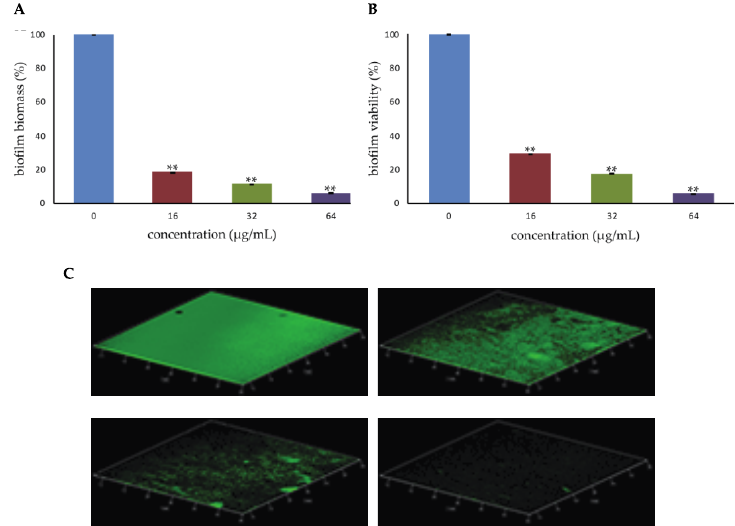
Figure 2. Eradicating e ff ect of PYED-1 on S. aureus preformed biofilm. Biofilm formed after 48 h in 96-well microplates was treated with di ff erent PYED-1 concentrations for 24 h at 37 ◦ C under static conditions. ( A ) Biofilm biomass were measured by crystal violet (CV) staining. ( B ) Biofilm viability was measured by tetrazolium salt reduction (XTT) assay. Error bars represent the standard deviation (SD) of three independent experiments. Asterisks indicate statistically significant di ff erences between the treated and untreated biofilms (** p < 0.01). ( C ) CLSM analysis of preformed S. aureus ATCC 29213 biofilm without treatment (left upper panel) or treated with PYED-1 at 16 µ g / mL (right upper panel), 32 µ g / mL (left inferior panel), and 64 µ g / mL (right inferior panel) for 24 h.